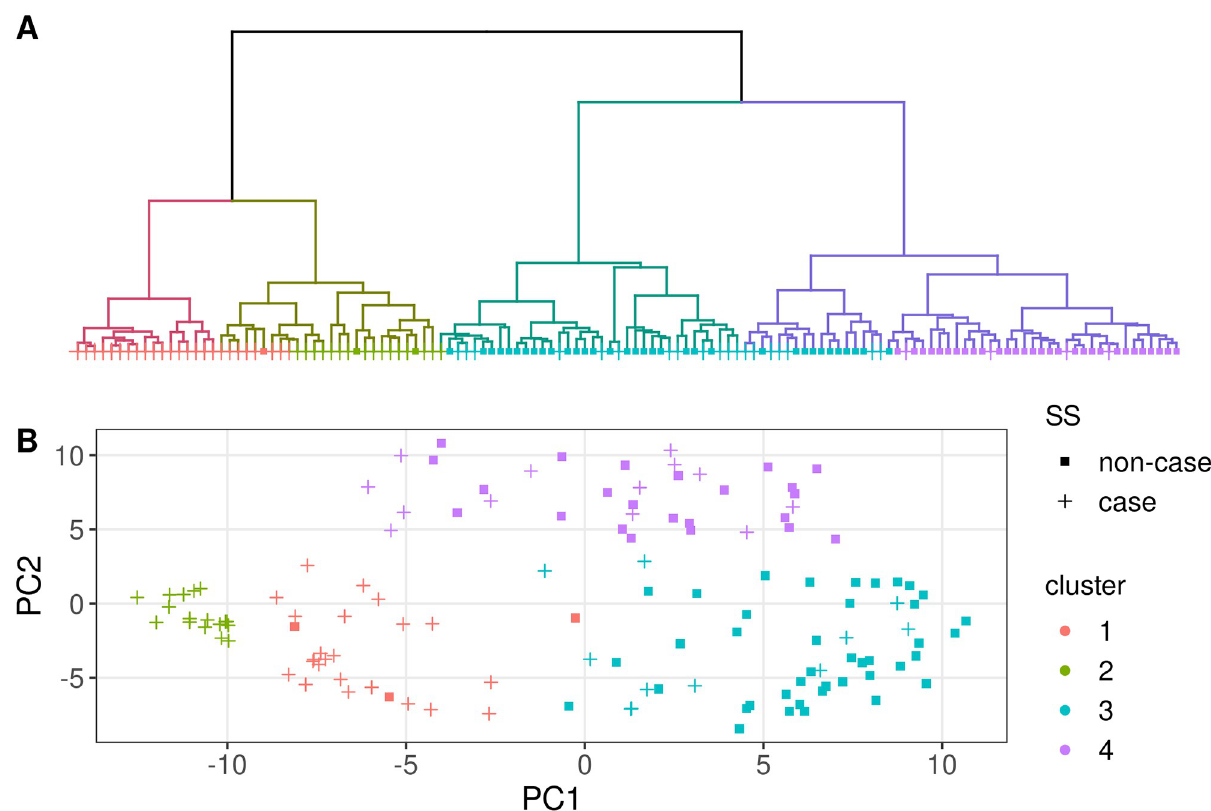
Fig 1. Clustering analysis of LSG (labial salivary gland) DNA methylation profiles. (A) Dendrogram from hierarchical clustering of VAE-based low dimensional embeddings from all 131 participants, with cluster numbering in the bottom and dendrogram cut height indicated by horizontal dotted line. (B) PCA plot of VAE-based low dimensional embeddings for all 131 study participants, with cluster numbering denoted by color and SS status denoted by shape.